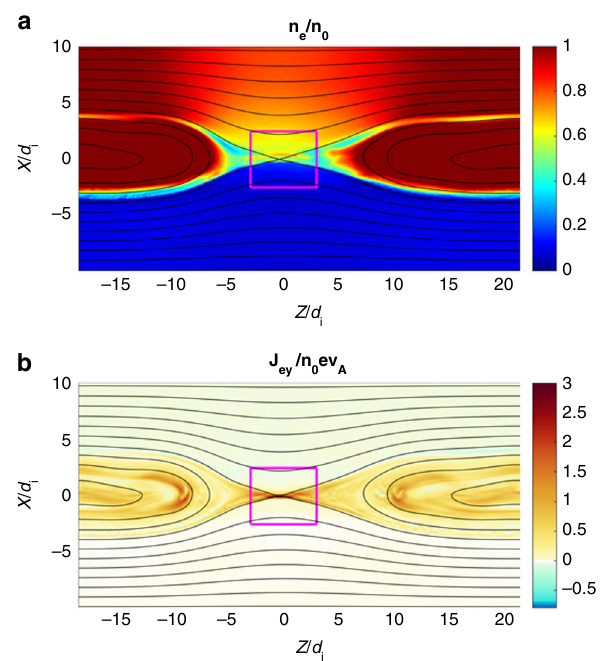
Fig. 7 Overview of VPIC simulations. The a density pro fi le and b out-of- plane electron current from the VPIC simulation of asymmetric reconnection are shown. The energy budget was evaluated over the magenta box centered on the X-line